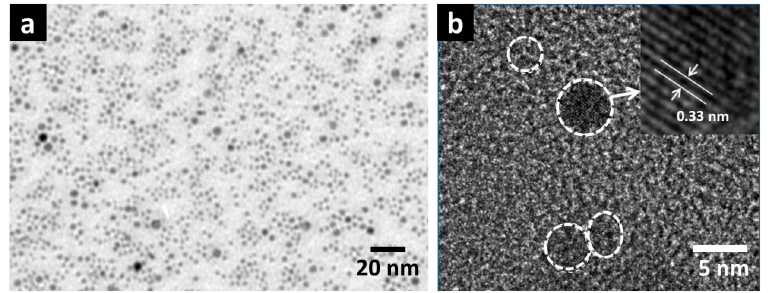
Figure 1. ( a ) TEM image of a small magnification view over ZnS NPs (nanoparticles) grown on copper mesh, and ( b ) a magnification at a few individual ZnS NPs. mesh, and ( b ) a magnification at a few individual ZnS